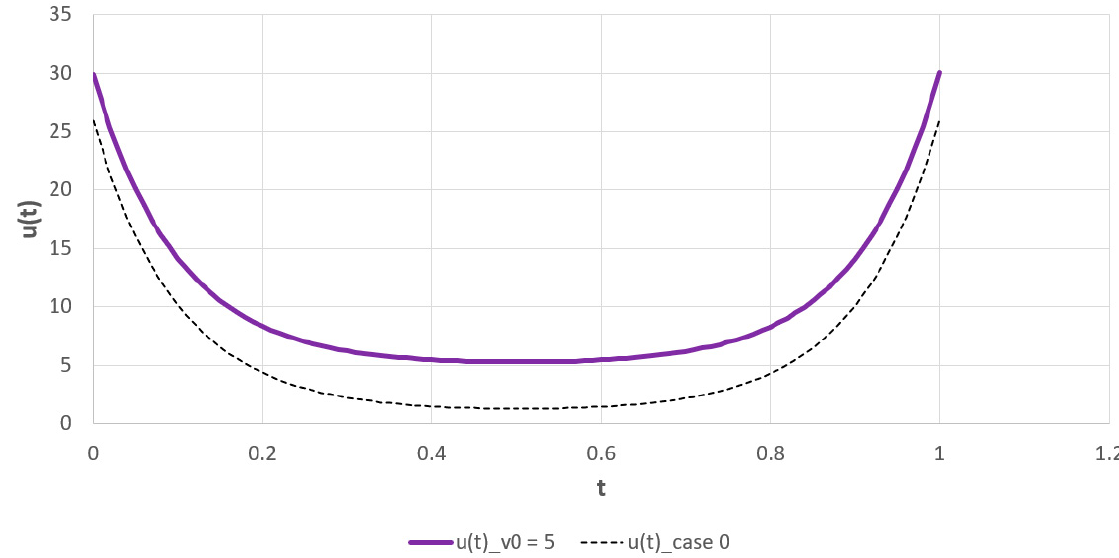
Figure 19. The optimal time path of u in Dynamic case 4.